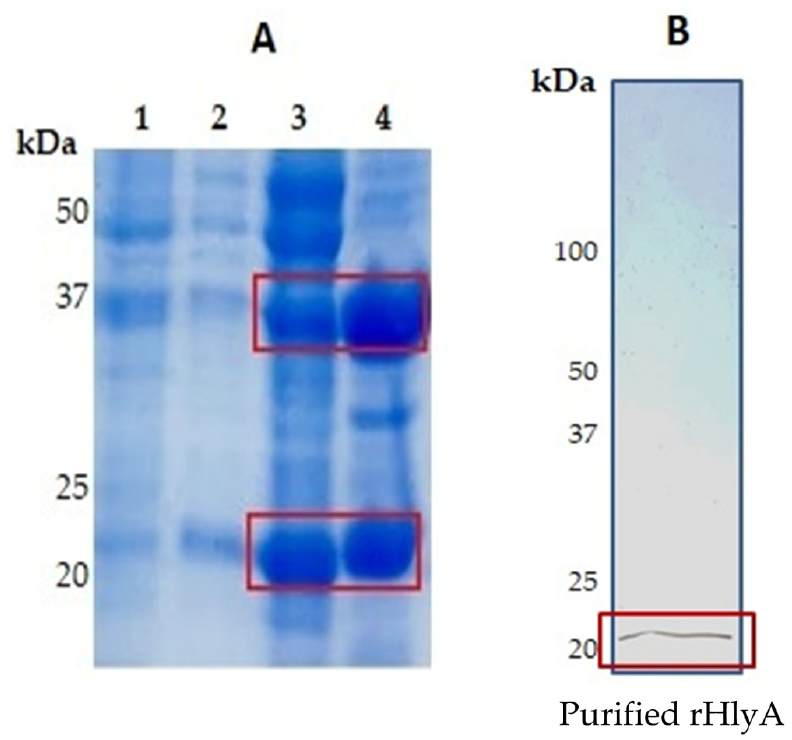
Figure 4. Twelve percent SDS-PAGE of the HlyA antigenic recombinant constructs: ( A ). SDS/PAGE Coomassie blue-stained: 1. Pre-induced; 2. Post-induced; 3. Disrupted supernatant; 4. Disrupted sediment. ( B ). SDS/PAGE silver-stained: purified rHlyA from affinity chromatography purification [(Nickel-loaded Sepharose (Ni 2+ )]. Table 3. Proteins identified by mass spectrometry.